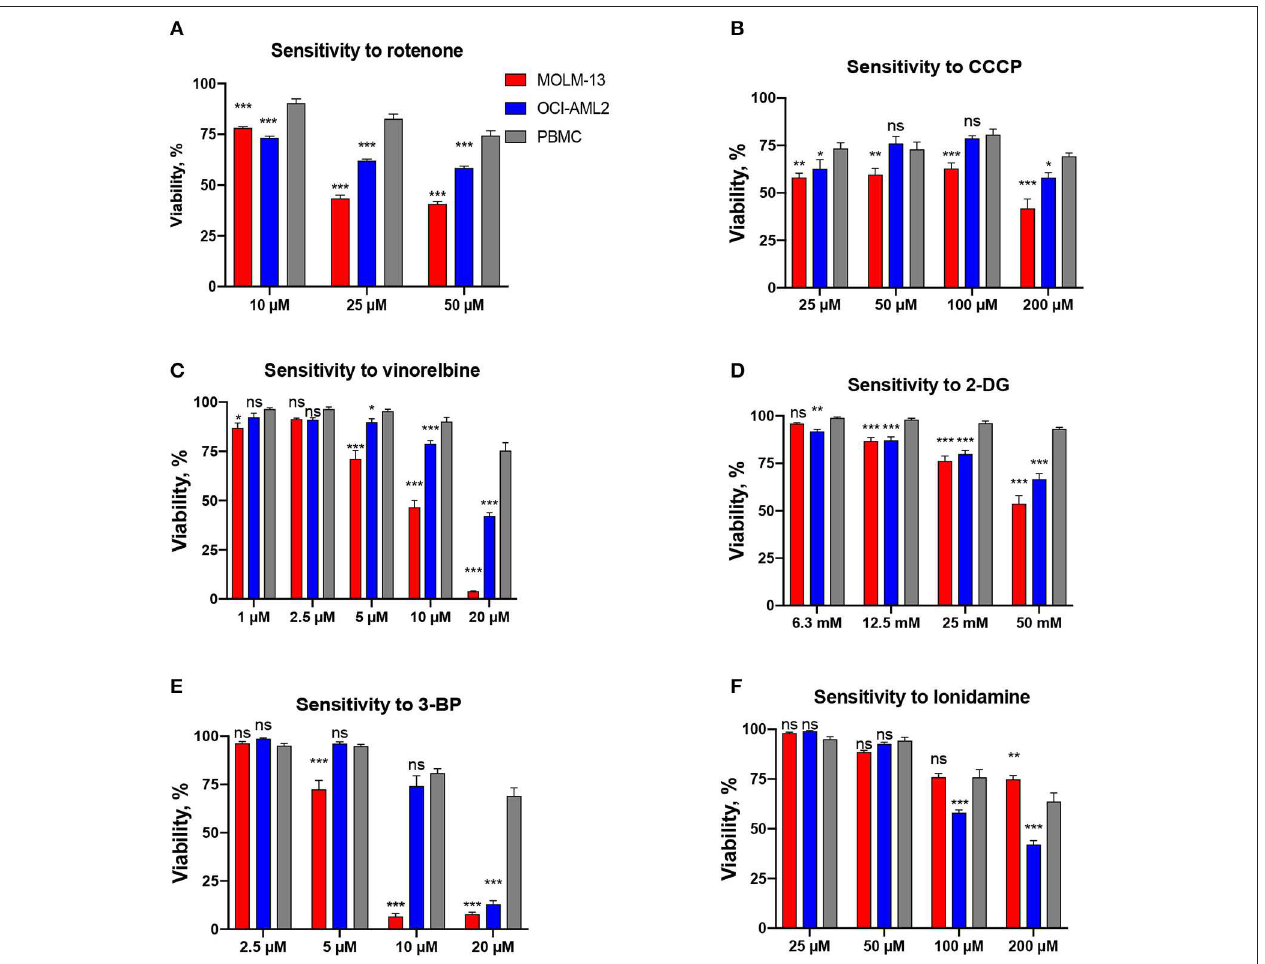
FIGURE 1 | Drugs included in the screen based on their selectivity toward AML cells. Survival of AML cells (OCI-AML2 or MOLM-13) or healthy PBMCs following 24h treatment with (A) rotenone, (B) CCCP, (C) vinorelbine, (D) 2-deoxy-D-glucose, (E) 3-bromopyruvate, (F) lonidamine. The average of at least three independent replicates ± SEM is shown. Significance of difference in survival (AML cells vs. PBMCs) was assessed via Student’s t -test. *** p < 0.001; ** p < 0.01; * p < 0.05; ns: p >